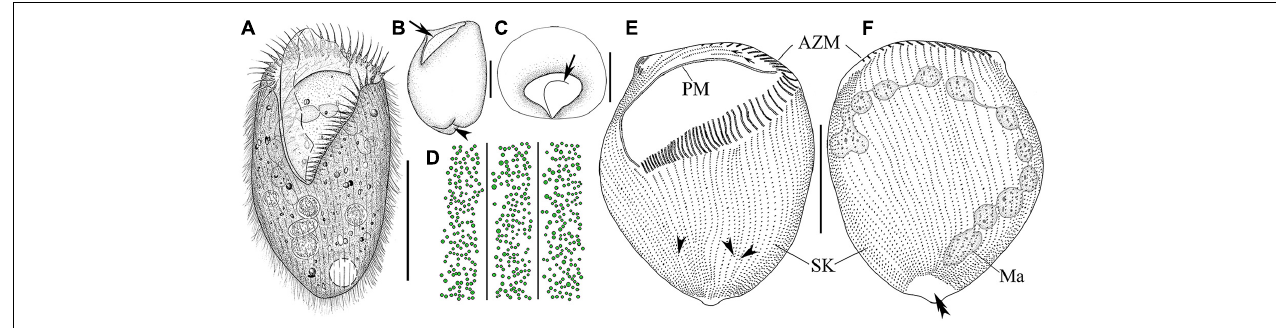
FIGURE 2 | Morphology and infraciliature of Linostomella pseudovorticella n. sp. (A–D) in vivo and (E , F) after protargol staining. (A) Ventral view of a representative individual. (B) Left lateral view of a living individual; arrowhead indicates the depression at posterior end of body, and arrow indicates the paroral membrane. (C) Apical view of a living cell; arrow indicates the paroral membrane. (D) Distribution of cortical granules on ventral side. (E , F) Ventral (E) and dorsal (F) view of the infraciliature of the holotype specimen; arrowheads indicate the locations where shortened kineties terminate posteriorly, and double arrowhead indicates the glabrous area. Abbreviations: AZM, adoral zone of membranelles; Ma, macronucleus; PM, paroral membrane; SK, somatic kineties. Scale bars = 100 µ m (A , E , F) , 50 µ m (B , C) .